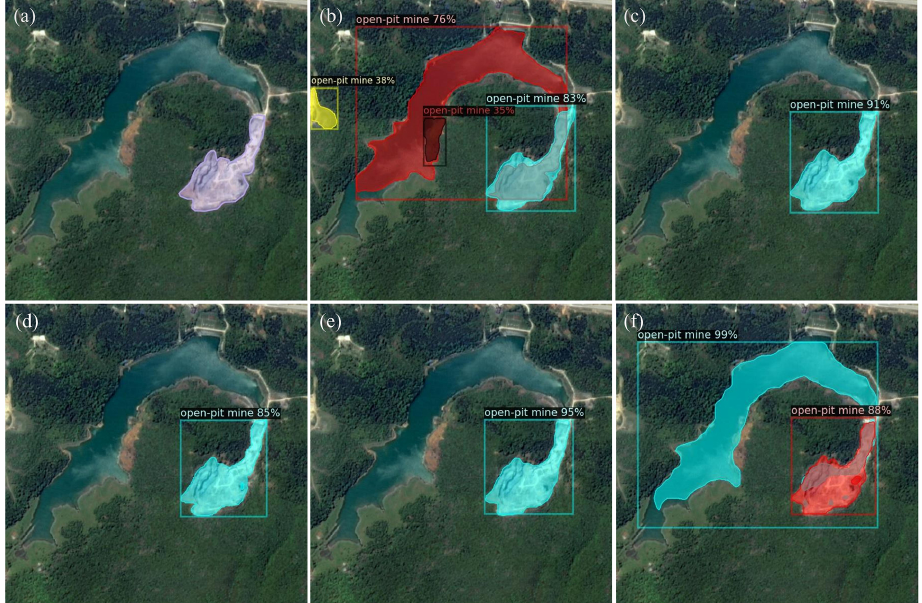
Figure 6. Model inference probabilities and shapes results on Gaofen satellite fusion image. ( a ) Ground truth of a limestone mine. ( b ) Inference result by BlendMask model; ( c ) inference result by BlendMask-VoV model; ( d ) inference result by CondInst model; ( e ) inference result by CondInst-VoV model; ( f ) inference result by the Mask R-CNN model.